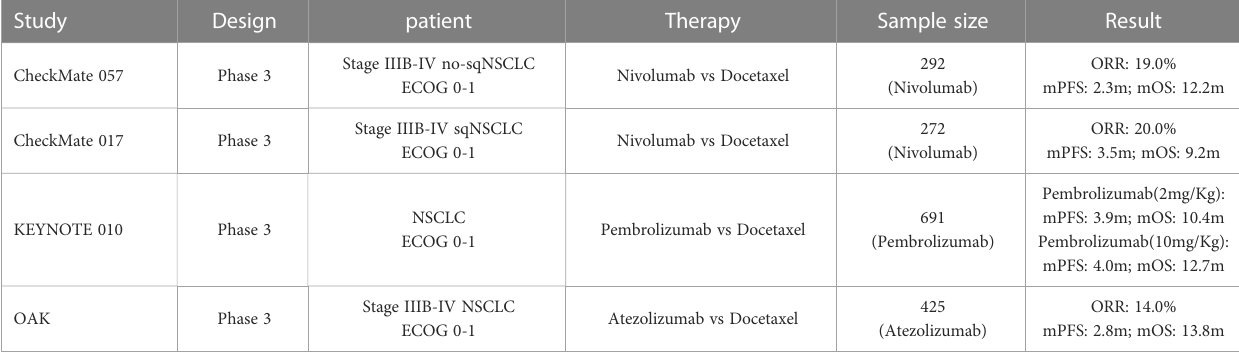
TABLE 5 Comparison of ICI monotherapy clinical